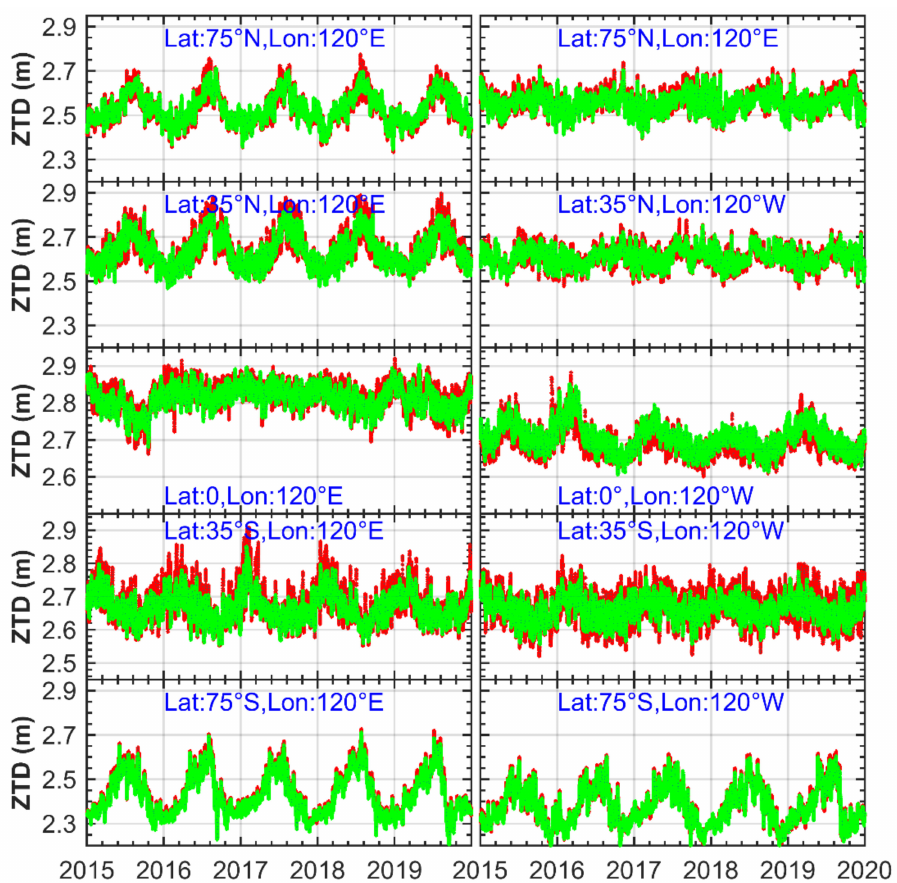
Figure 4. Tropospheric delay sequence diagram solved by ERA-5 and SH_set. Red spots indicate the tropospheric delay of the ERA-5 solution, and green spots indicate the tropospheric delay of the SH_set